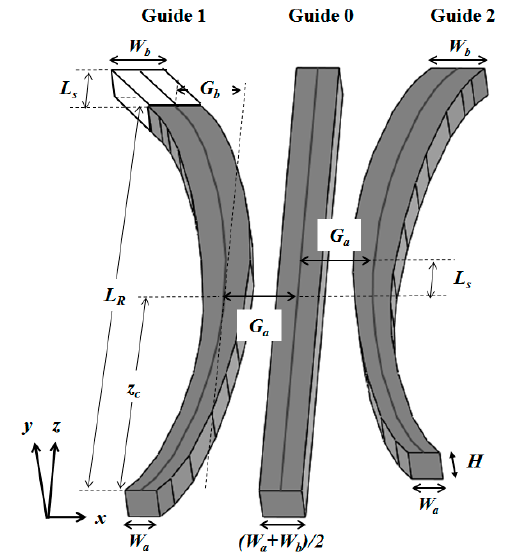
Figure 1. Schematic of the variable splitting ratio splitter with coupling-weighted and velocity-tapered waveguides (CVW) structure.